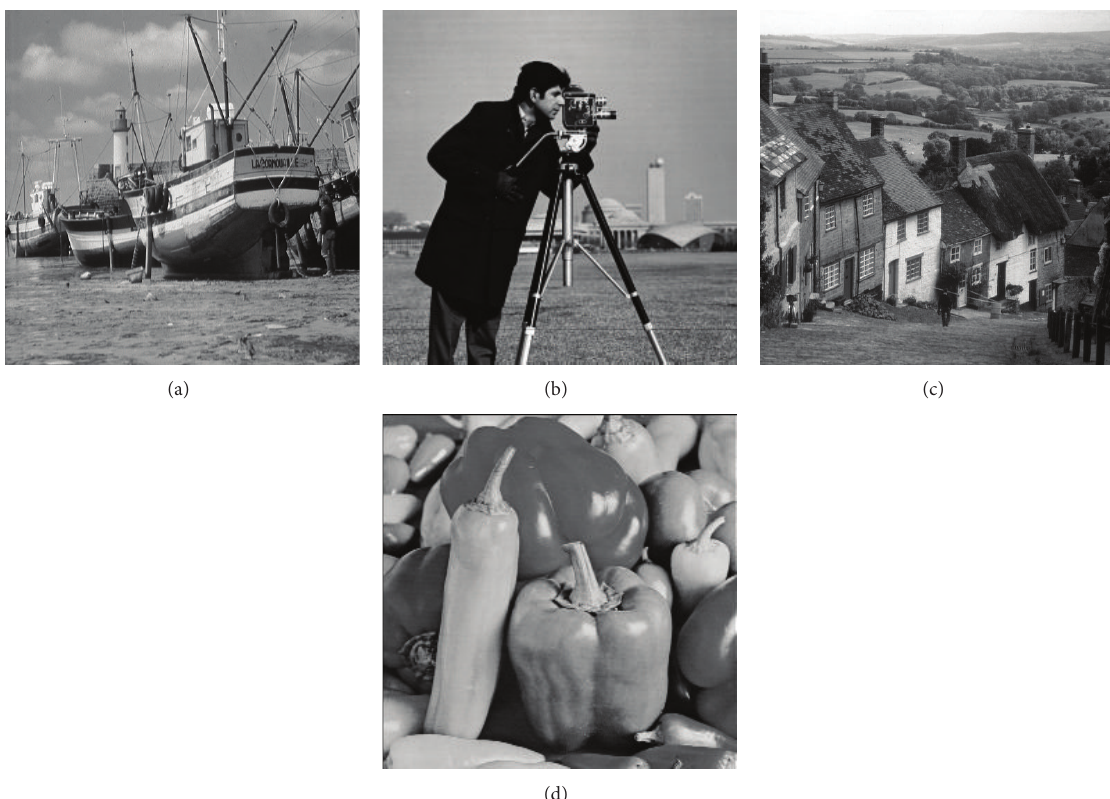
Figure 1: Sharp images. (a) Boat image with a resolution of 512 × 512 . (b) Cameraman image with a resolution of 256 × 256 . (c) Hill image with a resolution of 512 × 512 . (d) Peppers image with a resolution of 256 × 256 .